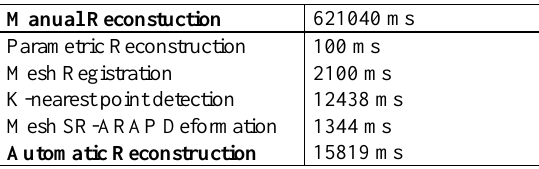
Table 1. Computation time for automatic demi-lune reconstruction